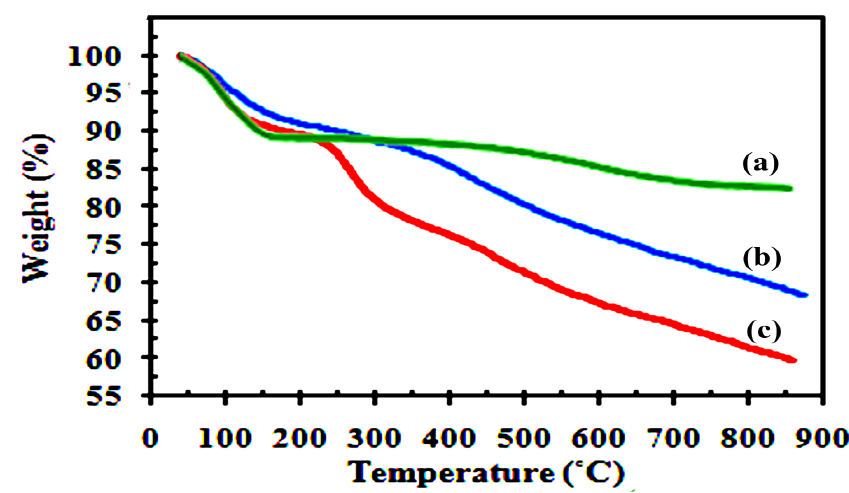
Figure 4. The thermogravimetric analysis curves of the ( a ) H ‐ BEN, ( b ) Ar ‐ BEN, and( c ) AS ‐ BEN.